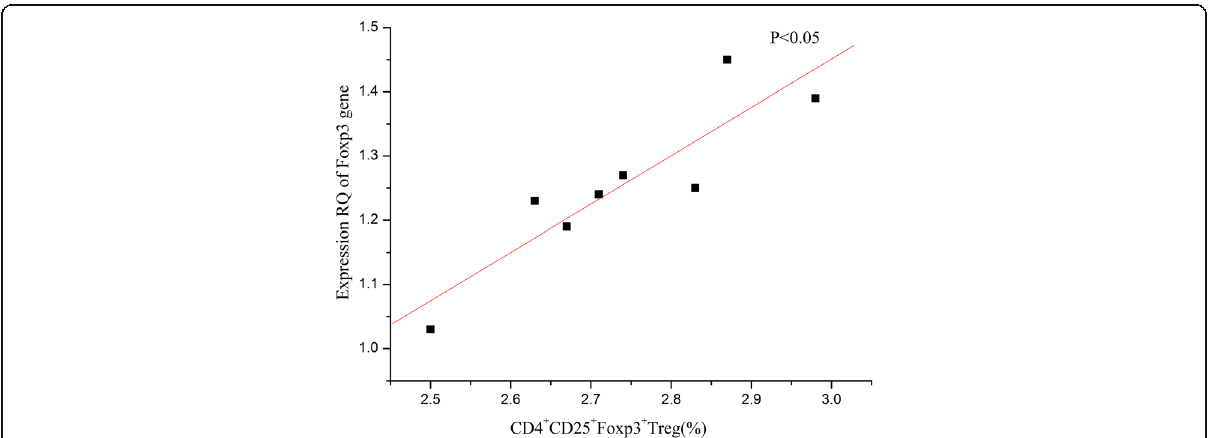
Fig. 6 Correlation of Tregs/T ratio and expression of Foxp3 transcription factor gene in high-dose FDPGLM group. The index of Tregs/T ratio was correlated to expression RQ of Foxp3 gene ( P <